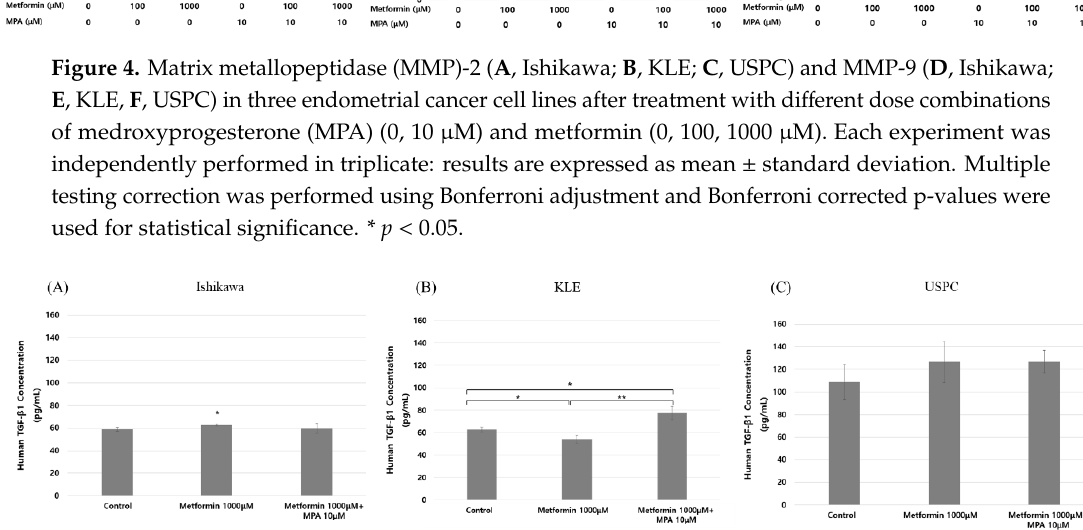
Figure 5. Transforming growth factor (TGF)- β 1 in three endometrial cancer cell lines after treatment with different dose combinations of medroxyprogesterone (MPA) (0, 10 µM) and metformin (0, 1000 µM) in Ishikawa ( A ), KLE ( B ), and USPC cells ( C ). Each experiment was independently performed in triplicate: results are expressed as mean ± standard deviation. Multiple testing correction was performed using Bonferroni adjustment and Bonferroni corrected p -values were used for statistical significance. * p < 0.05, ** p < 0.005.